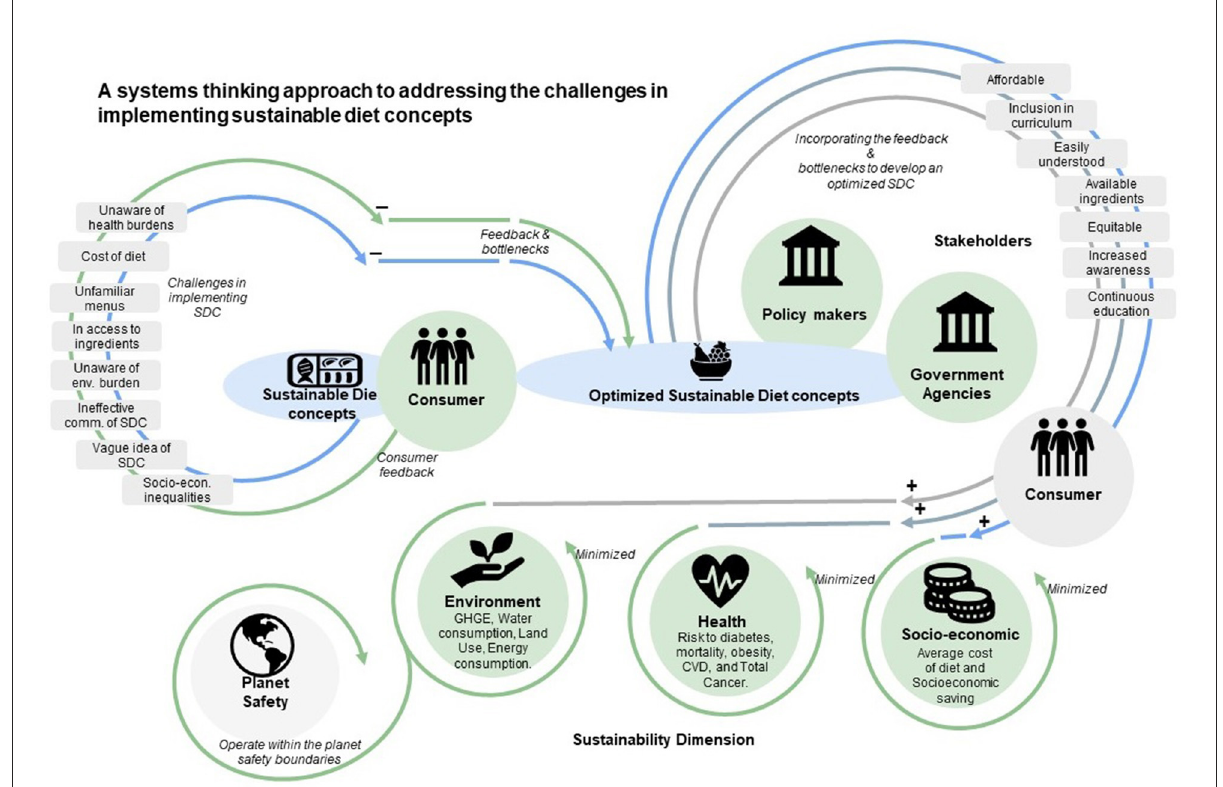
FIGURE11 A system thinking approach to address the challenges of scaling up sustainable diet concepts to an optimized diet